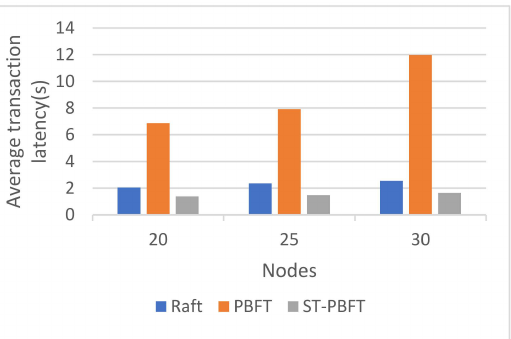
Figure 12. The transaction latency of the three consensus algorithms. PBFT is from [13], Raft is from